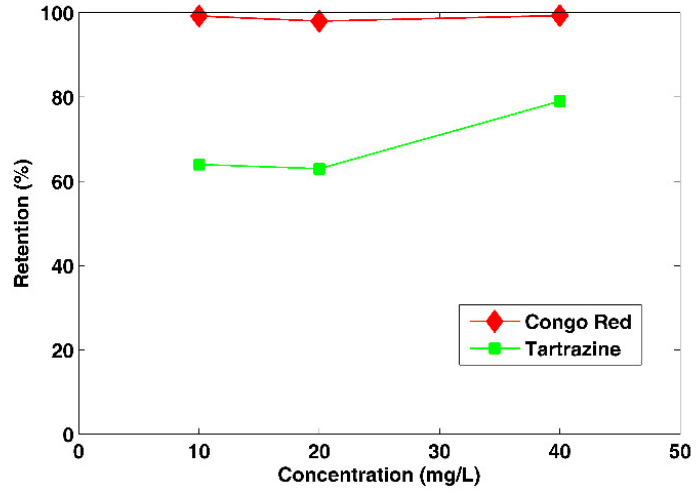
Figure 10. Effect of initial concentration on retention of Congo Red and Tartrazine.